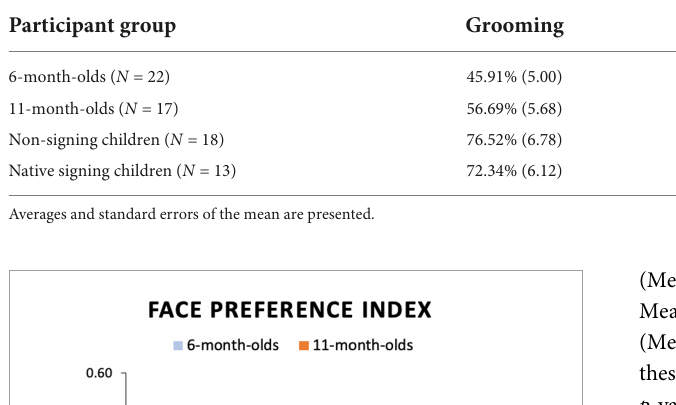
TABLE 2 Percent gaze recorded for each stimulus condition, normalized by video duration.